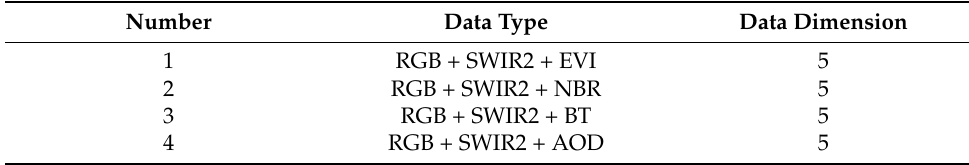
Table 7. Fusion of different remote sensing features.